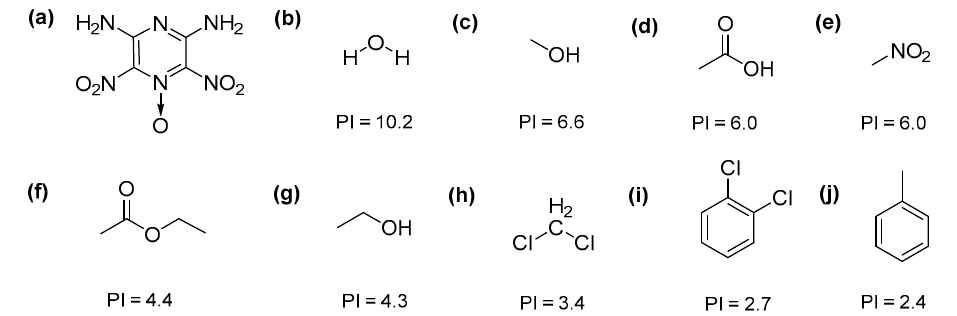
Figure 1. Molecular structures of ( a ) 2,6-diamino-3,5-dinitropyrazine-1-oxide (LLM-105), ( b ) H 2 O, ( c ) CH 3 OH, ( d ) CH 3 COOH, ( e ) CH 3 NO 2 , ( f ) CH 3 COOC 2 H 5 , ( g ) C 2 H 5 OH, ( h ) CH 2 Cl 2 , ( i ) C 6 H 4 Cl 2 , and ( j ) C 6 H 5 CH 3 .